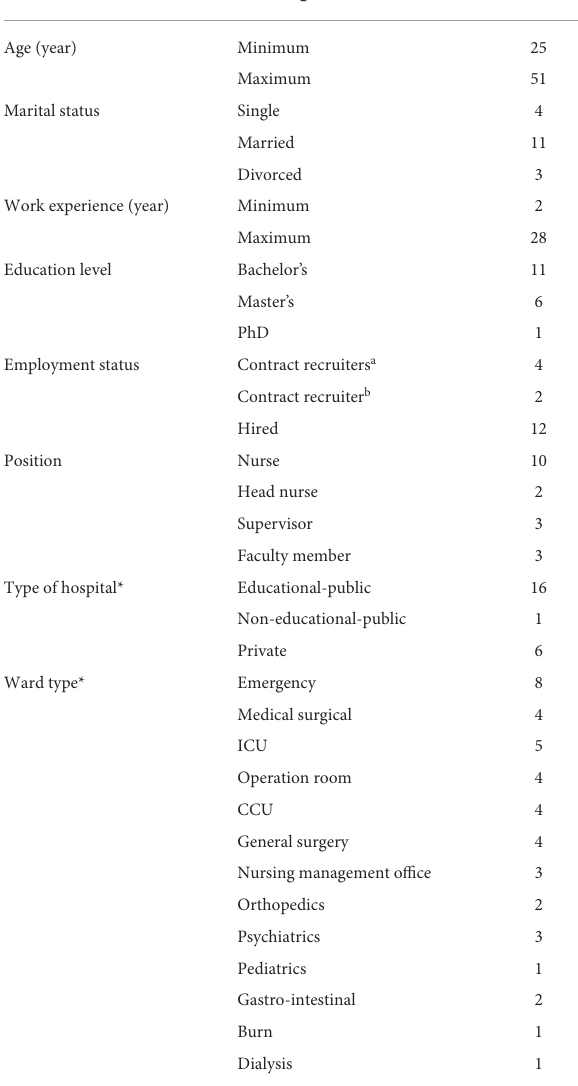
TABLE 1 Participants’ characteristics ( N =